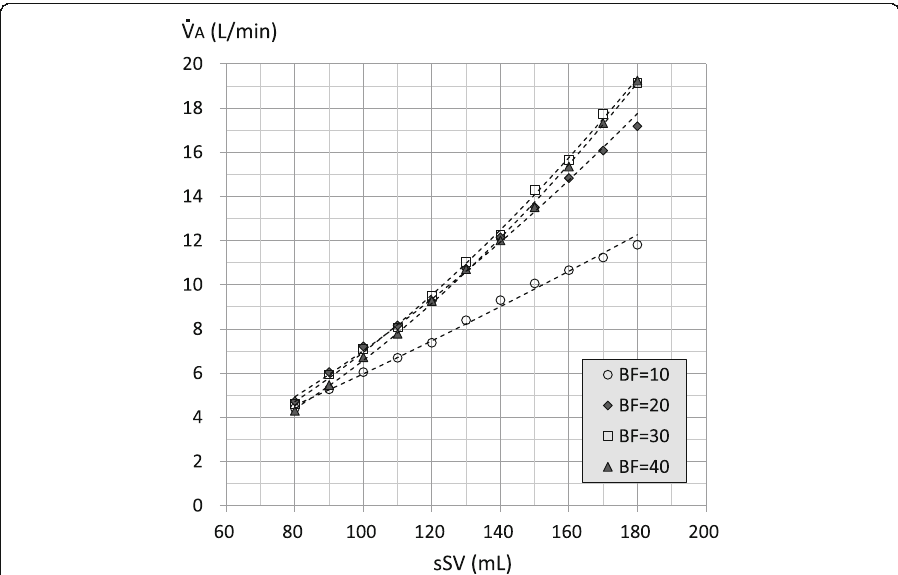
Fig. 3 Relationship between setting stroke volume (sSV) and alveolar ventilation ( _ VA). Legend: Marker indicates the sSV and mean value of _ VA ( n =5). Standard deviation is not indicated. The results of the statistical significance test are as follows: BF=10 vs BF=20, P <0.001 with all sSV; BF=10 vs BF=30, P <0.01 with sSV=80, P <0.001 with SV=90 – 180; BF=10 vs BF=40, P <0.05 with sSV=80 – 90, P <0.001 with sSV=100 – 180; BF=20 vs BF=30, P < 0.05 with sSV = 80, 130, and 150, ns with sSV = 90 – 120 and 140, P < 0.01 with sSV = 160, P < 0.001 with sSV = 170 – 180; BF = 20 vs BF = 40, P < 0.001 with sSV = 80 – 100 and 170 – 180, P < 0.01 with sSV = 110, ns with sSV = 120 – 160; and BF = 30 vs BF = 40, P < 0.001 with sSV = 80 – 100, P < 0.05, with sSV = 110, 130, and 150, ns with sSV = 120, 140, and 160 – 180. Dotted curves are power approximations. The perfect powers (coefficient of correlation: R , P value) are as follows: BF = 10: 1.226 ( R = 0.995, P < 0.001); BF = 20: 1.580